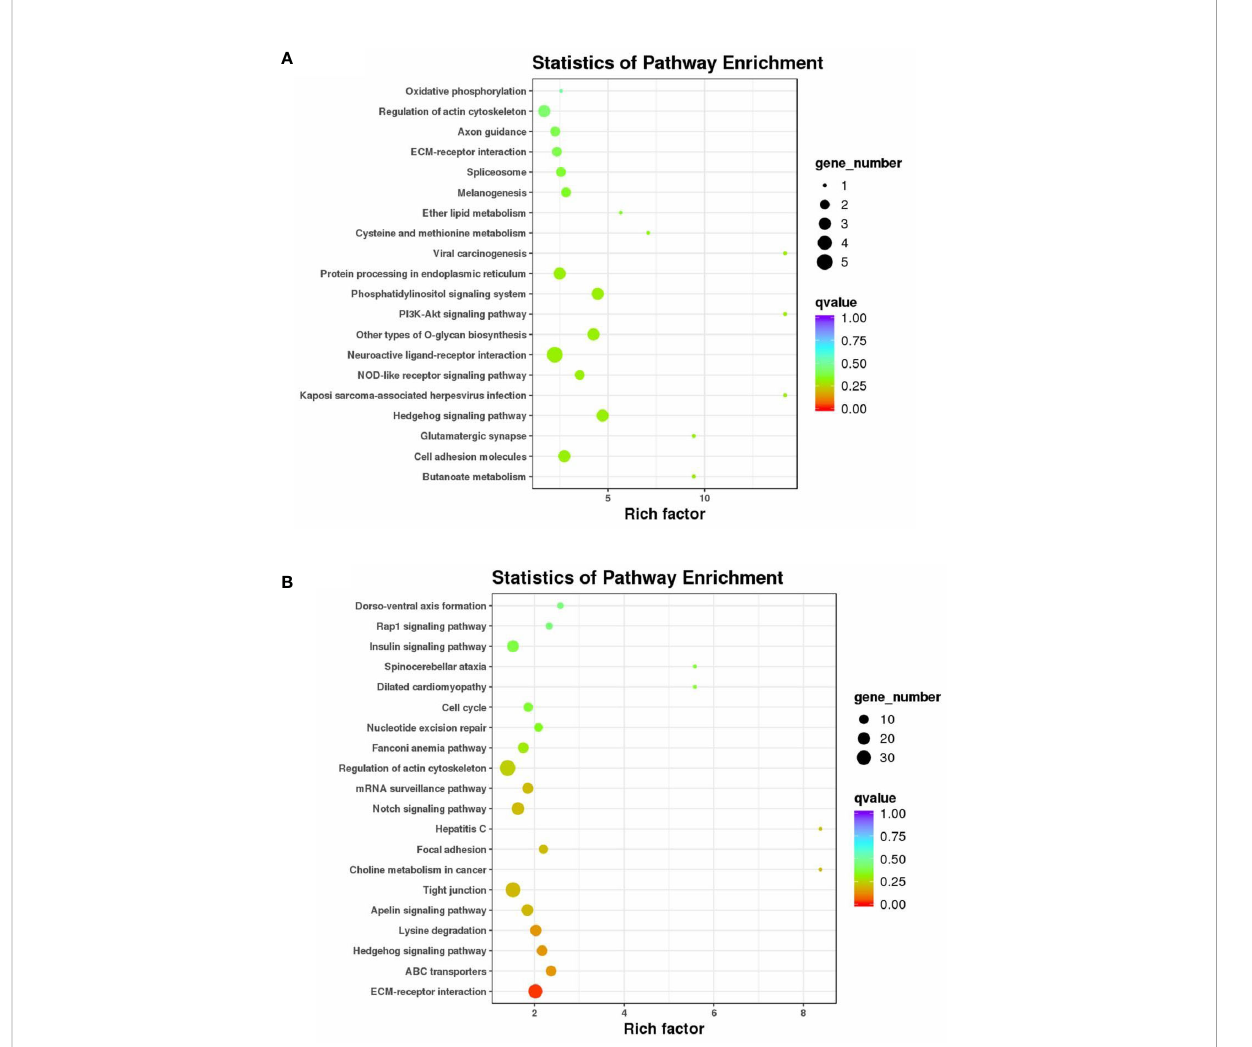
FIGURE 4 KEGG pathway enrichment analysis of the host genes of DE circRNAs and the target genes of DE miRNAs. KEGG enrichment of the host genes of DE circRNA (A) and the target genes of DE miRNAs (B) . The color of the dot represents the q -value for each pathway. The size of the dot represents the number of genes enriched in each